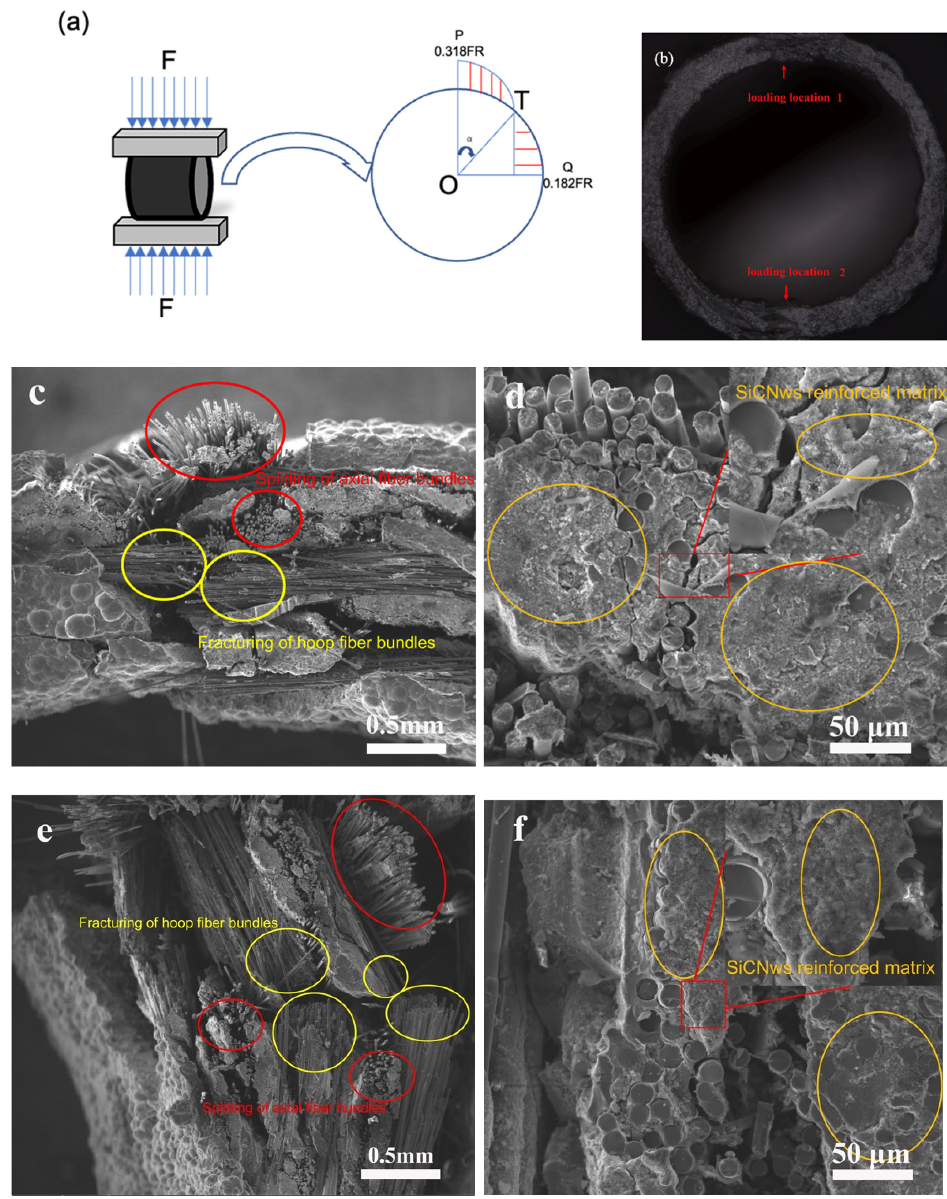
Figure 11. ( a ) Schematic of the bending moment distribution under radial compressive loading [31]; ( b ) fracture location of the SiC f /SiC composites; and ( c – f ) fracture morphology at ( c , d ) α = 0° and ( e , f ) α = 90°.